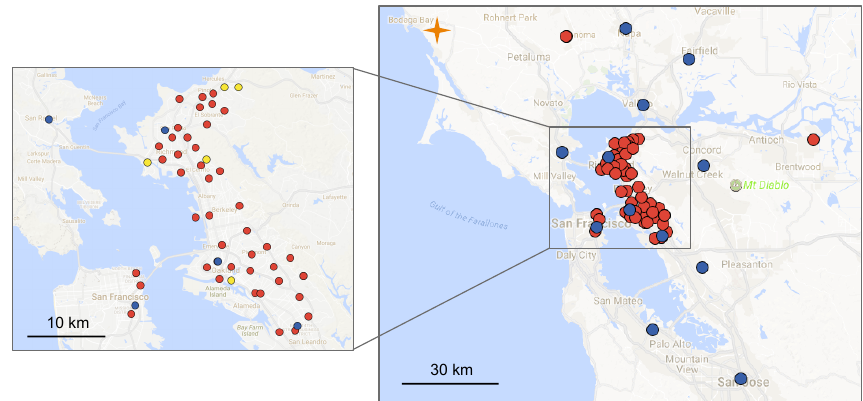
Figure 1. Map of San Francisco Bay Area showing current BEACO 2 N node sites (red), BAAQMD reference sites with O 3 measurements (blue), and the BAAQMD Bodega Bay regional greenhouse gas background site (orange). The sites used in this analysis are marked in yellow on the detailed panel.